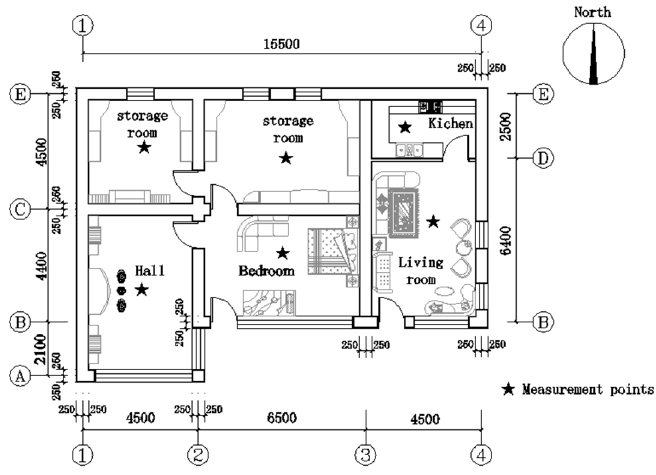
Figure 2. Schematic diagram of the testing building and test point location.